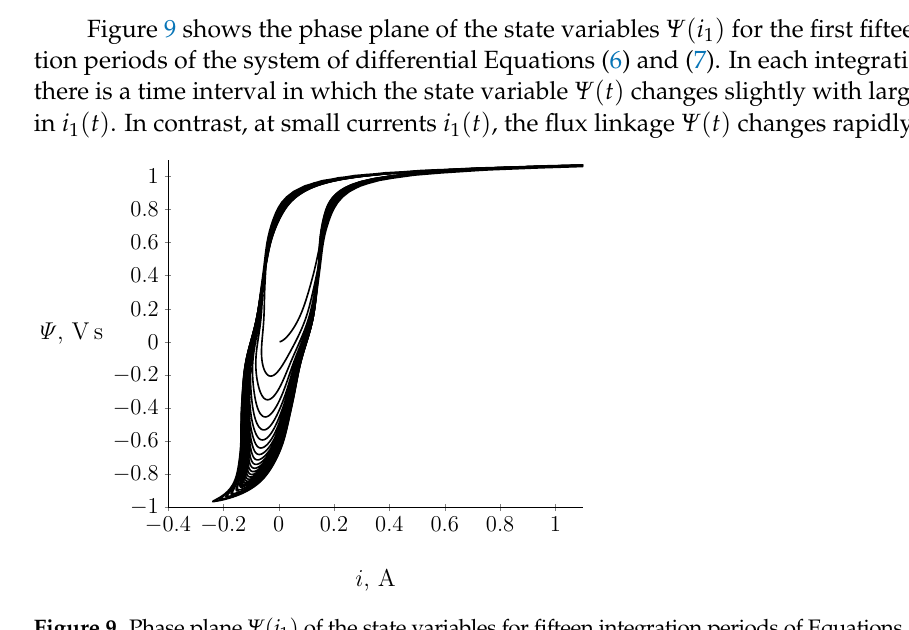
Figure 8. The decimal logarithm of the norm of the error vector estimated in the calculation process according to Formula (25) for the case shown in Figure 6.